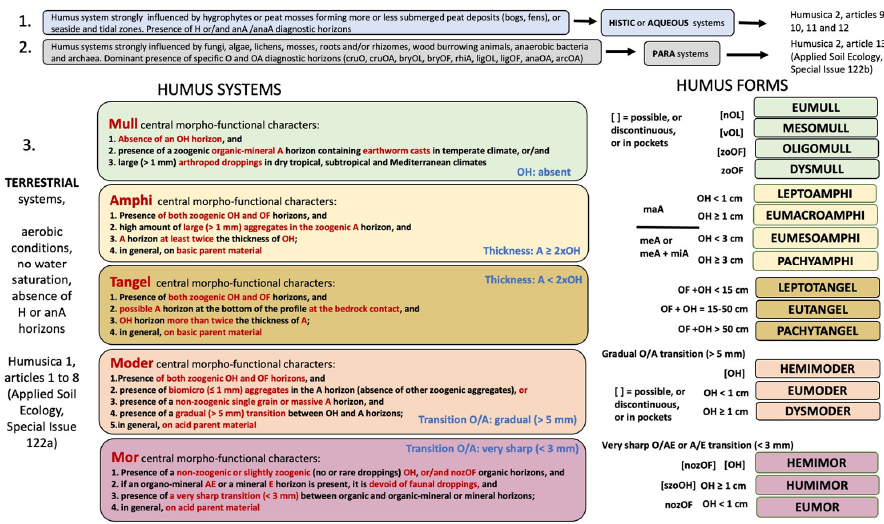
Figure 3. Main terrestrial humus systems ( left ) subdivided into humus forms ( right ). Modified from